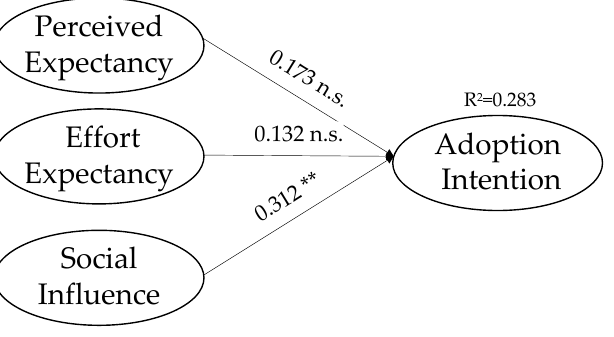
Figure 3. The results of the UTAUT baseline model. Note: ** p < 0.01; n.s.: no significance.